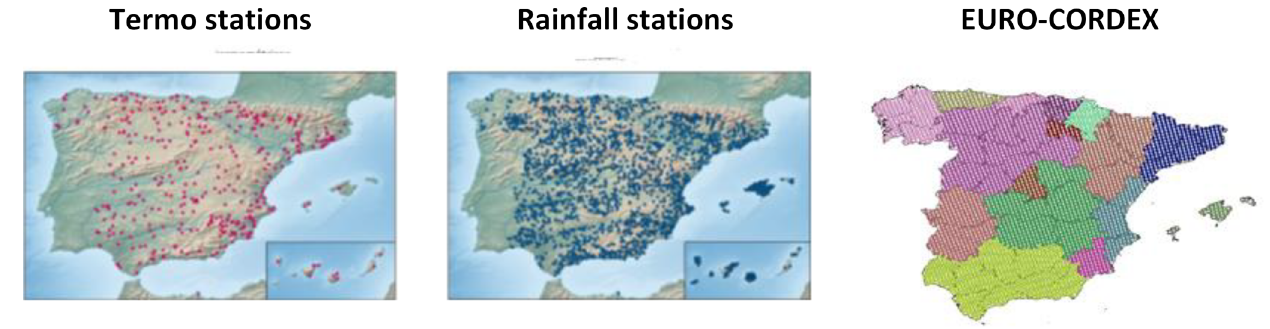
Figure 6. Spatial distribution of climatological stations used in the regionalization of temperature (374) and precipitation (2323) and spatial distribution of gridpoints of